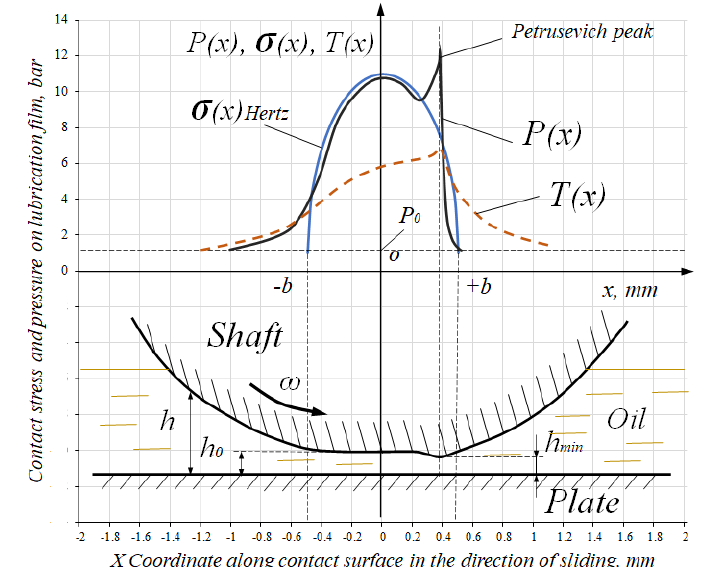
Fig. 6. Scheme of the Elasto-hydrodynamic friction model, where its main provisions are reflected: 1. The elastically deformed surfaces of the curvilinear contact are parallel; 2. The lubricating layers are strongly compressed from h ; 3. The distribution of pressure in above and below by parallel compressing surfaces and have a constant thickness 0 p and is identical to the contact the lubricating film p(x) (EHL pressure) is everywhere greater than atmospheric 0 stresses σ(x) according to G. Hertz, that is, p(x)=σ(x); 4. Contact stresses in the output region have a “Petrusevich h , which peak”, where the temperature Т is maximum, and the thickness of the lubricating film is minimum min R R  ; 5. Direct contact of the surfaces is not provided, therefore should exceed the sum of surface roughness   1 2 a a friction according to the Elasto-hydrodynamic model is theoretically